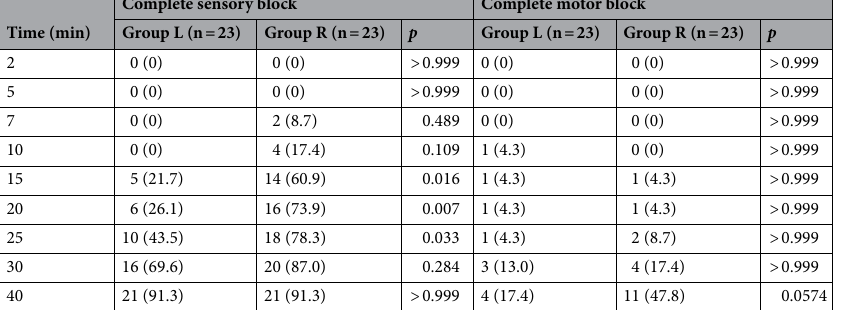
Table 2. The success rate of complete sensory and motor blockade at each time point. Data are presented as number (%).